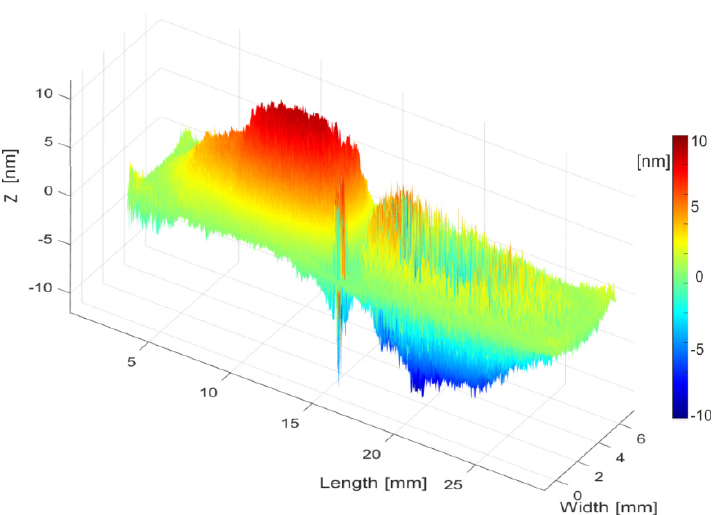
Figure 10. Picture of the optically measured 3D vibration of the detected resonance at 19.4 kHz in the fabricated cell. The modal shape corresponds to the out-of-plane 32-mode. The color scale represents the out-of-plane deformation when the cell patches were excited at 5 V.